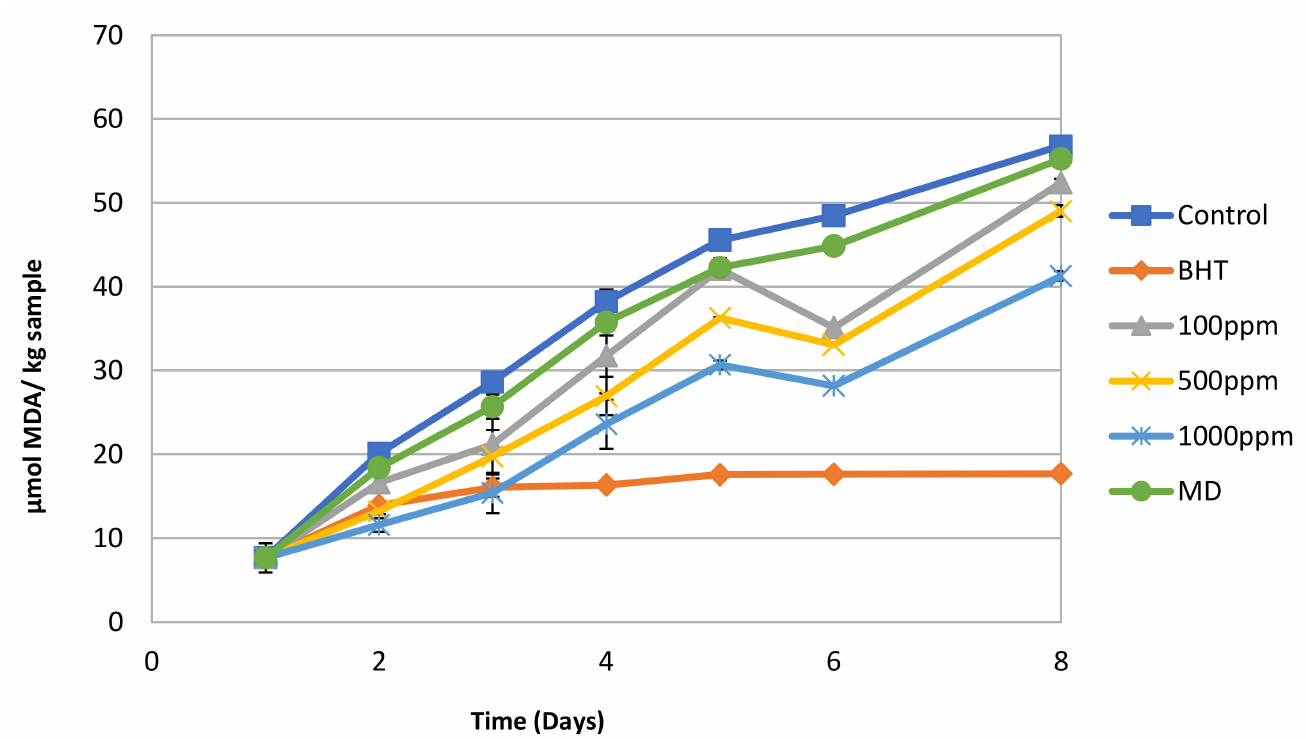
Figure 2. TBARS of bovine mince samples during refrigerated (4 ◦ C) storage. All samples were comprised of 40 g mince and 10 mL DI water, in which the corresponding amount of the spray-dried concentrate was dissolved. The BHT sample contained 100 ppm BHT dissolved in 8 mL DI water